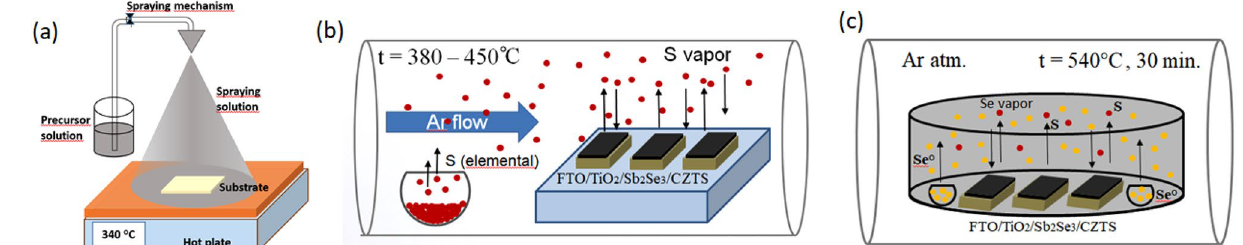
Figure 1. Experimental procedure for obtaining CZTSSe films. Schematic representation of the preparation of CZTS films by spray pyrolysis ( a ), followed by sulfurization ( b ) and subsequent formation of CZTSSe films by selenization ( c )